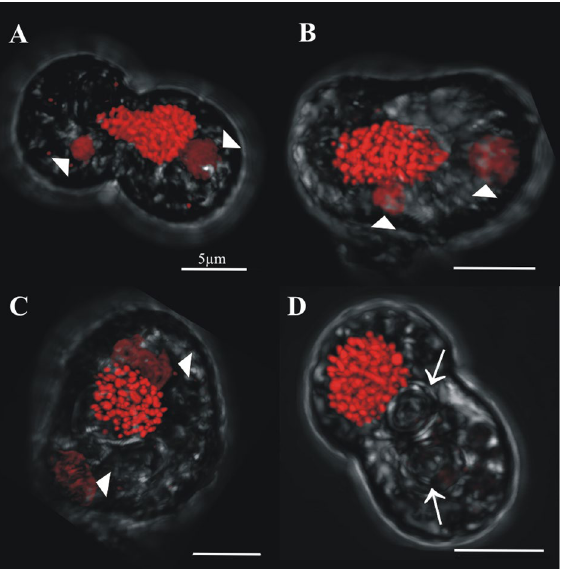
Figure 6. Confocal images of sorted cells in the 2C DNA content gate and with one single nucleus, interpreted as undergoing the meiotic cycle. These cells have duplicated pyrenoids (arrows) and accumulation bodies